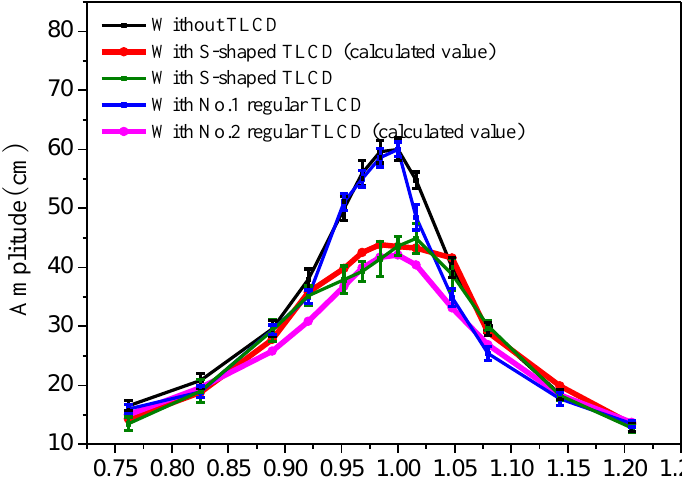
Figure 4. Experimental and calculated vibration amplitude